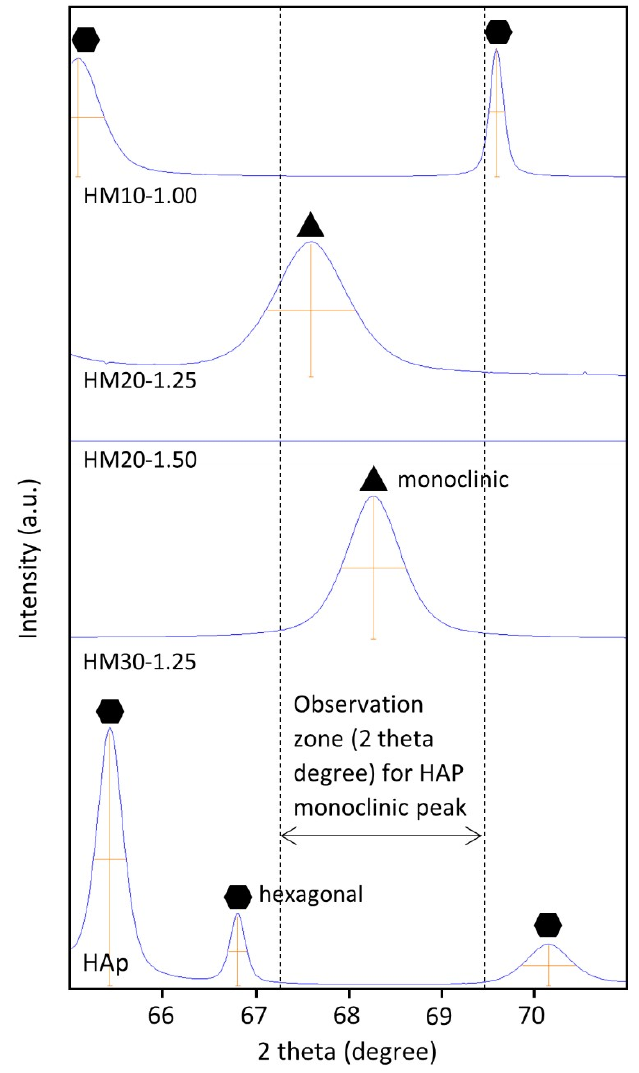
Figure 5. Magnified region at 65–71° 2 θ indicates a monoclinic peak observed within the range of 67° to 69° 2 θ for HM20-1.25 and HM30-1.25.